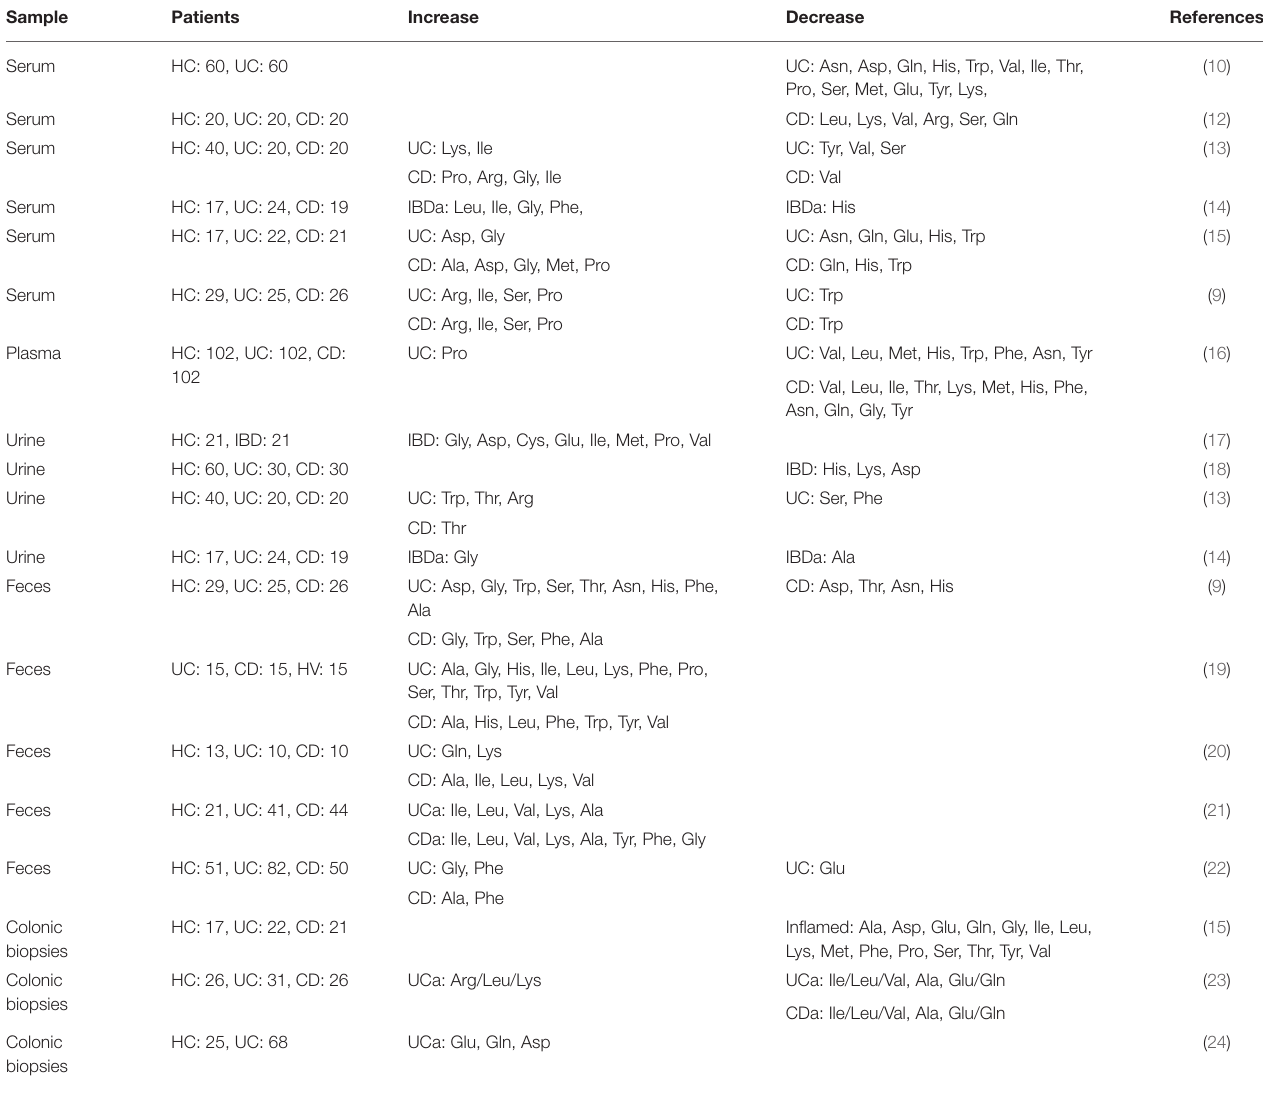
TABLE 1 | Comparison of amino acid levels between healthy subjects and IBD patients. Sample Patients